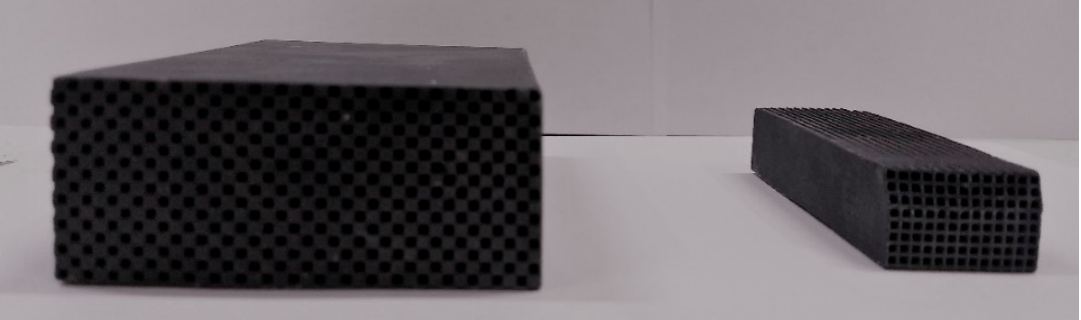
Figure 8. Silicon carbide monoliths, wall-flow type ( left ) and flow-through type ( right